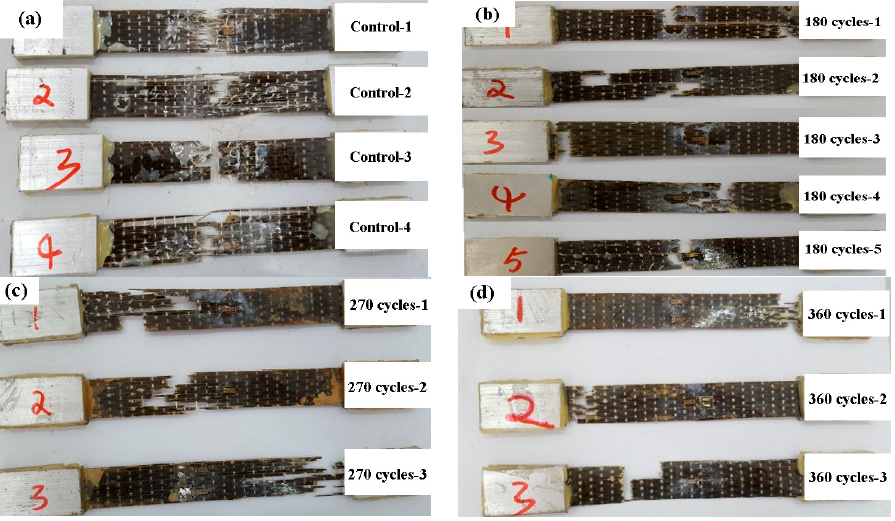
Figure 9. Failure modes of BFRP sheets, ( a ) control; ( b ) 180 cycles; ( c ) 270 cycles; ( d ) 360 cycles.